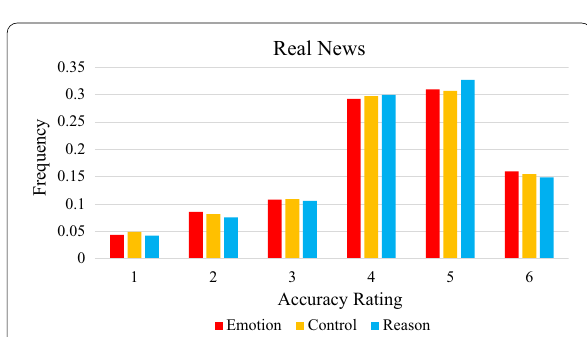
Fig. 5 All three conditions produce similar accuracy ratings of real news